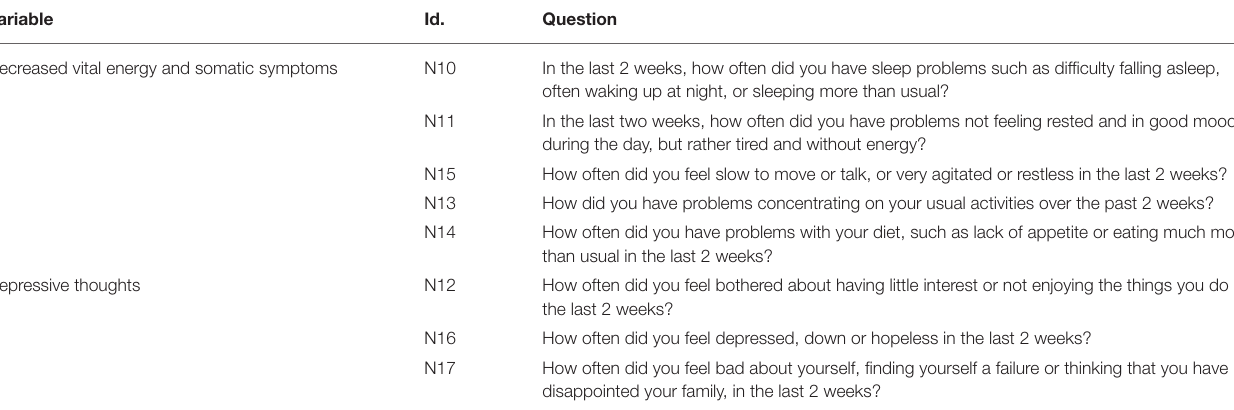
TABLE 1 | Description of the construction of the dependent variables according to the 2013 Brazilian National Health Survey. Variable